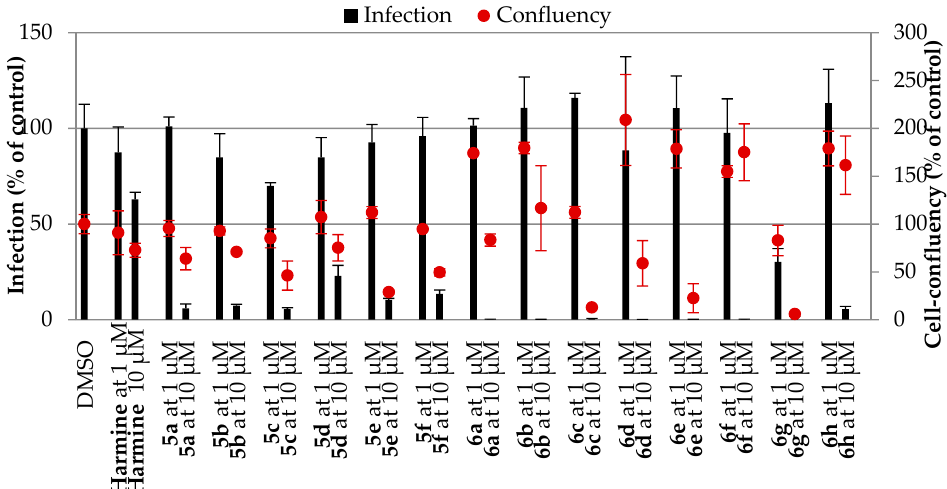
Figure 2. In vitro activity against P. berghei liver stages of harmicines 5a – f and 6a – h at 1 and 10 µ M concentrations. Total parasite load (infection scale, bars) and cell viability (cell confluency scale, dots) are shown. Results were normalized to the negative control, DMSO, and are represented as mean ± SD, n = 1.